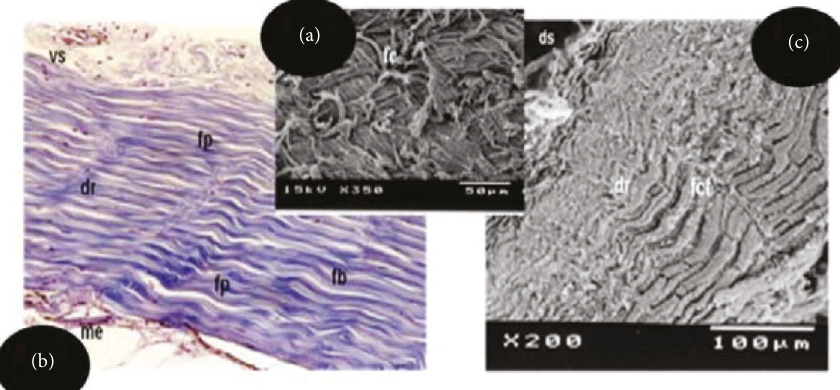
Figure 5: (a) Photomicrograph of histological section Nile tilapia leather illustrating the superficial dermis containing blood vessels (vs) and deep dermis formed by overlapping layers of parallel and longitudinal collagen fibers (fp). In the hypodermal layer, the presence of melanophores (me) is observed. Staining: Masson’s trichrome. Objective lens: 20x; (b) scanning electron micrograph of the superficial dermis (ds) and deep dermis (dp), in which the overlapping layers of parallel collagen fibers interspersed by the transverse fibers (fct) are observed. Magnitude: 200x. Bar: 100 μ m; (c) scanning electron micrograph showing the interweaving of the collagen fibers (fc) of the superficial dermis. Magnitude: 350x. Bar: 50 μ m. Table 1: Average thickness values and determination of the progressive tearing tests of the Nile tilapia and rabbit leather specimens. Progressive tearing